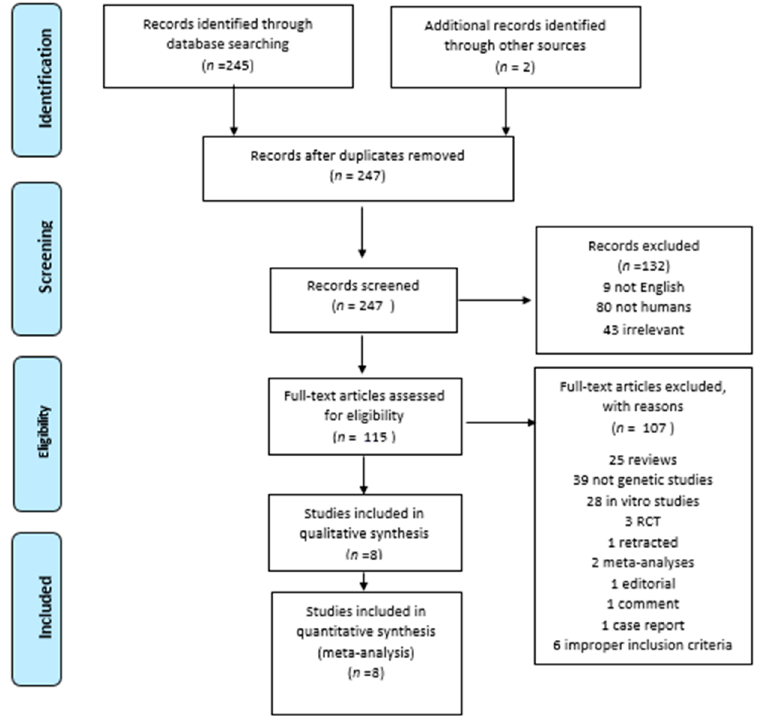
Figure 1. Flowchart of retrieved studies with reasons of exclusion.